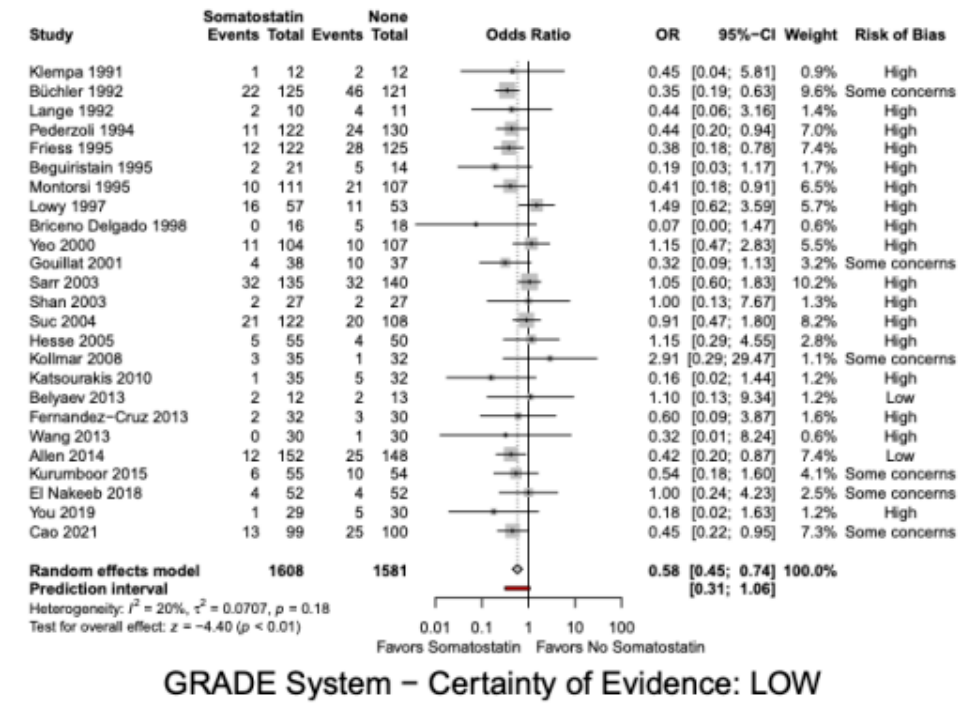
Figure 3. Postoperative Pancreatic Fistula, Somatostatin analogues.